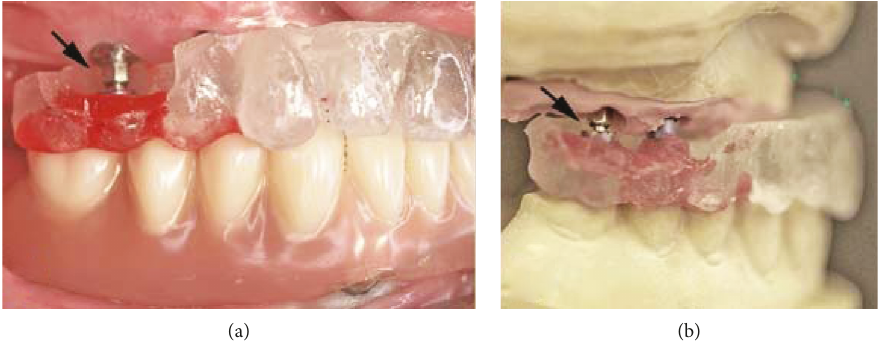
Figure 6: (a) DentDu retained on BATTs in occlusion and (b) articulated master cast with the BATTs and DentDu.